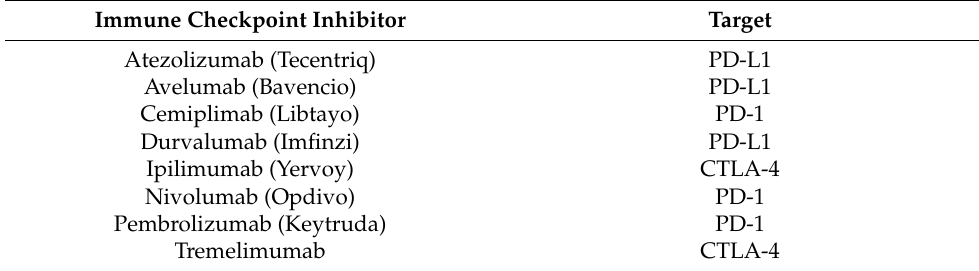
Table 1. Immune checkpoint inhibitors in current clinical